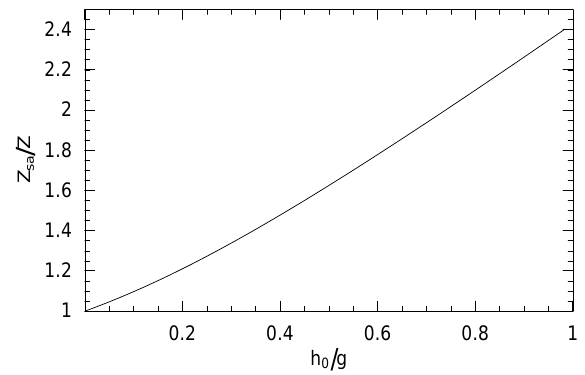
FIG. 5. Ratio of the small-angle approximation impedance (cid:90) (cid:115)(cid:97) , Eq. (56), and (cid:90) given by Eq. (57) as a function of the triangle aspect ratio. A comparison of the two results is shown in Fig.